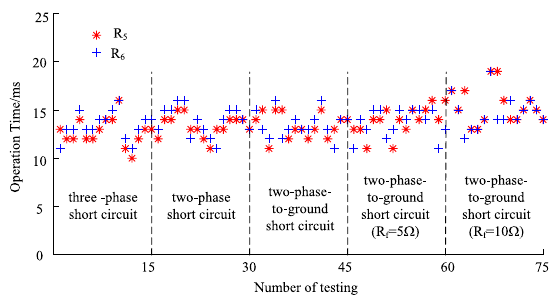
Fig. 13 Operation time of the prototype